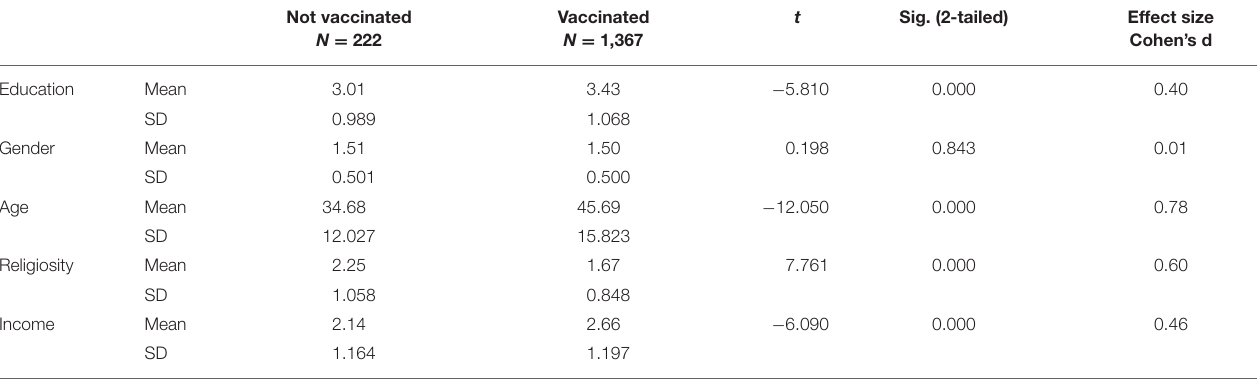
TABLE 2 | T -tests comparing the demographic characteristics of individuals vaccinated three times vs. none-vaccinated